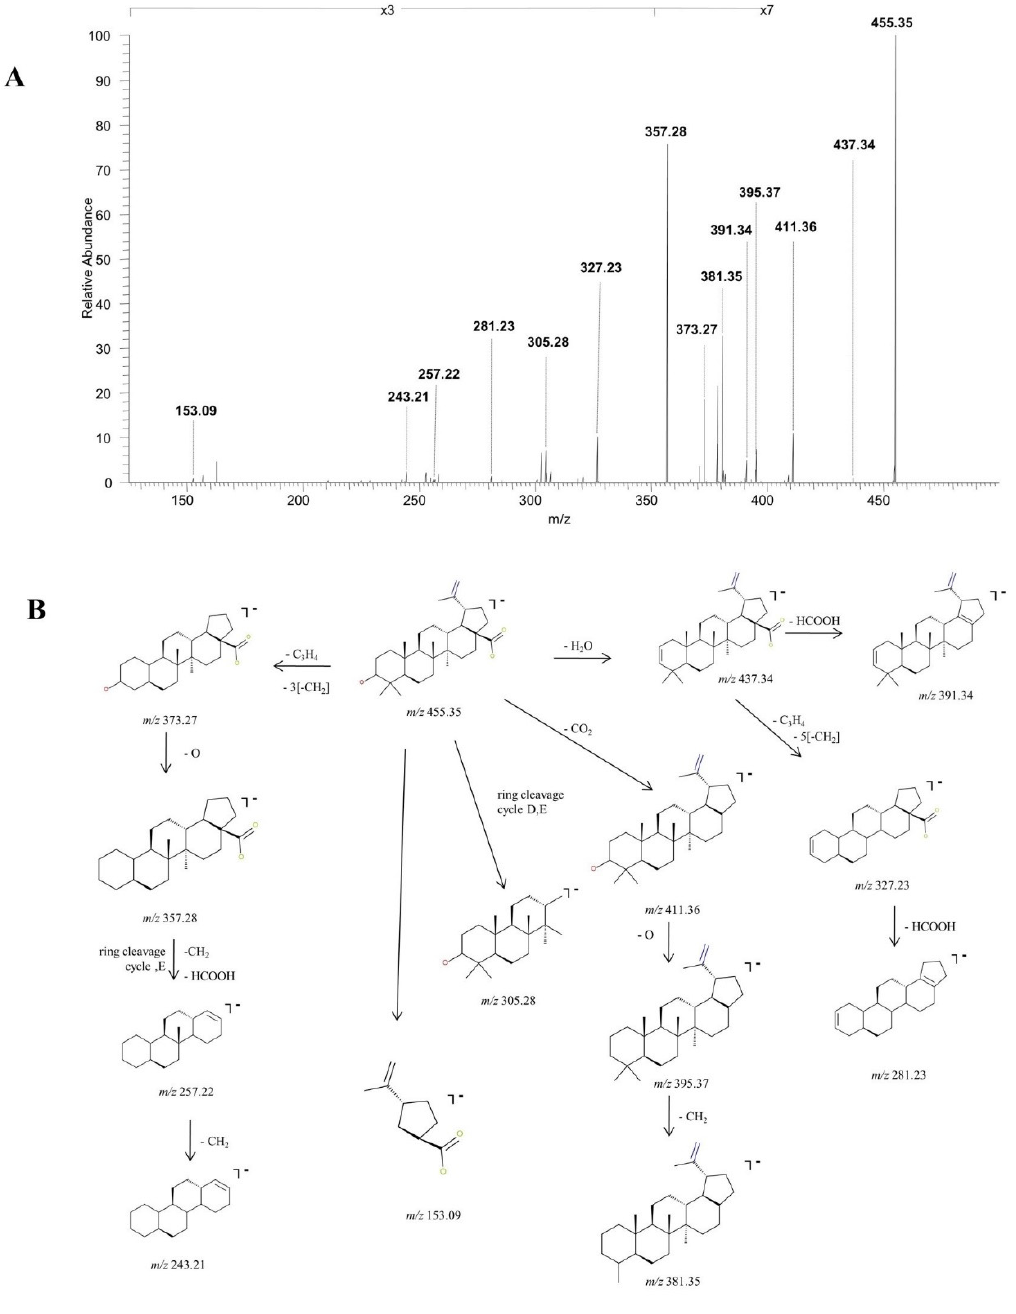
Figure 2. Structural characterization of betulinic acid (BA) (3 β , hydroxy-lup-20(29)-en-28-oic acid). ( A ) ESI CID MS/MS spectra of the [M − H] − ion detected at m/z 455.35 in the negative ion mode: spray voltage 0.70 kV, capillary temperature 275 °C and collision energies within 0–35 eV. ( B ) Proposed fragmentation pathway.